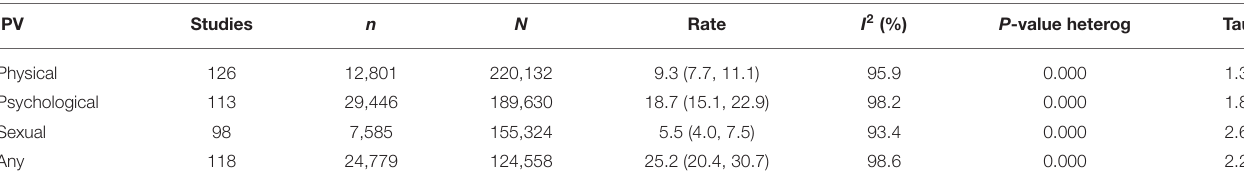
TABLE 1 | Meta-analysis by type of intimate partner violence (IPV) during pregnancy.